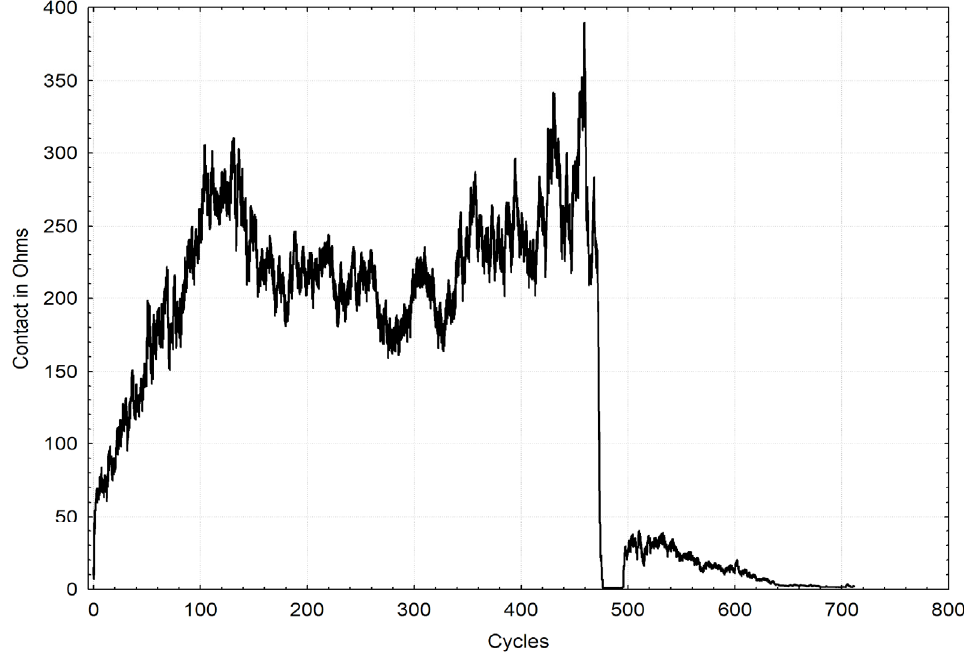
Figure 6. Selected graph of the durability of the “black” ZA200 coating.